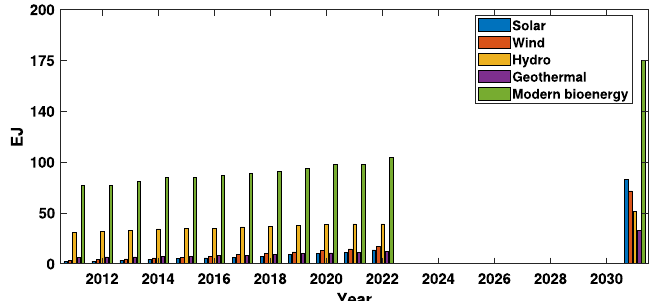
Figure 1. Renewable electricity generation growth by technology net scenario, 2010–2030.